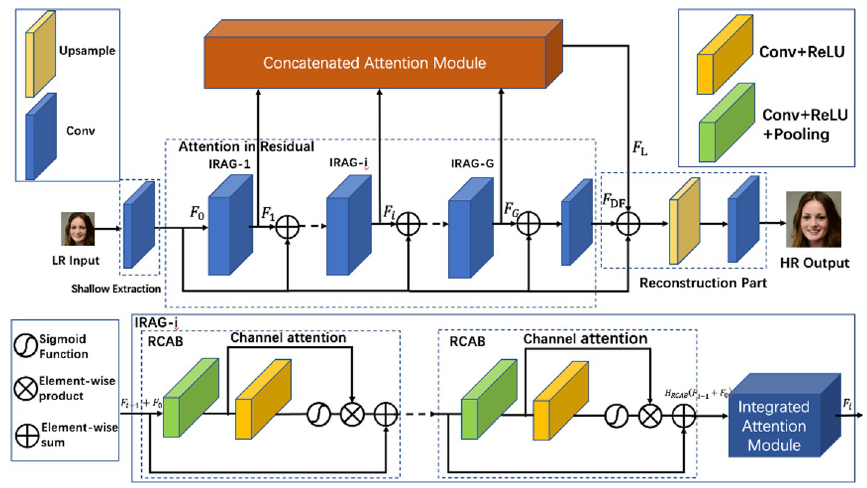
Fig 1. The network architecture of our